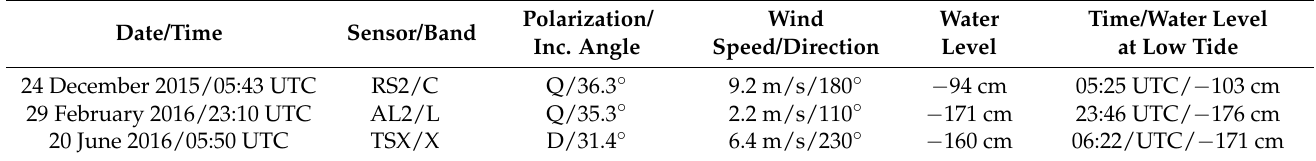
Table 1. SAR acquisition dates and times, sensors and radar bands, acquisition modes, and environmental conditions during image acquisitions. Water levels are geopotential heights measured at pile “Wittdün”. Polarizations: dual-co-pol